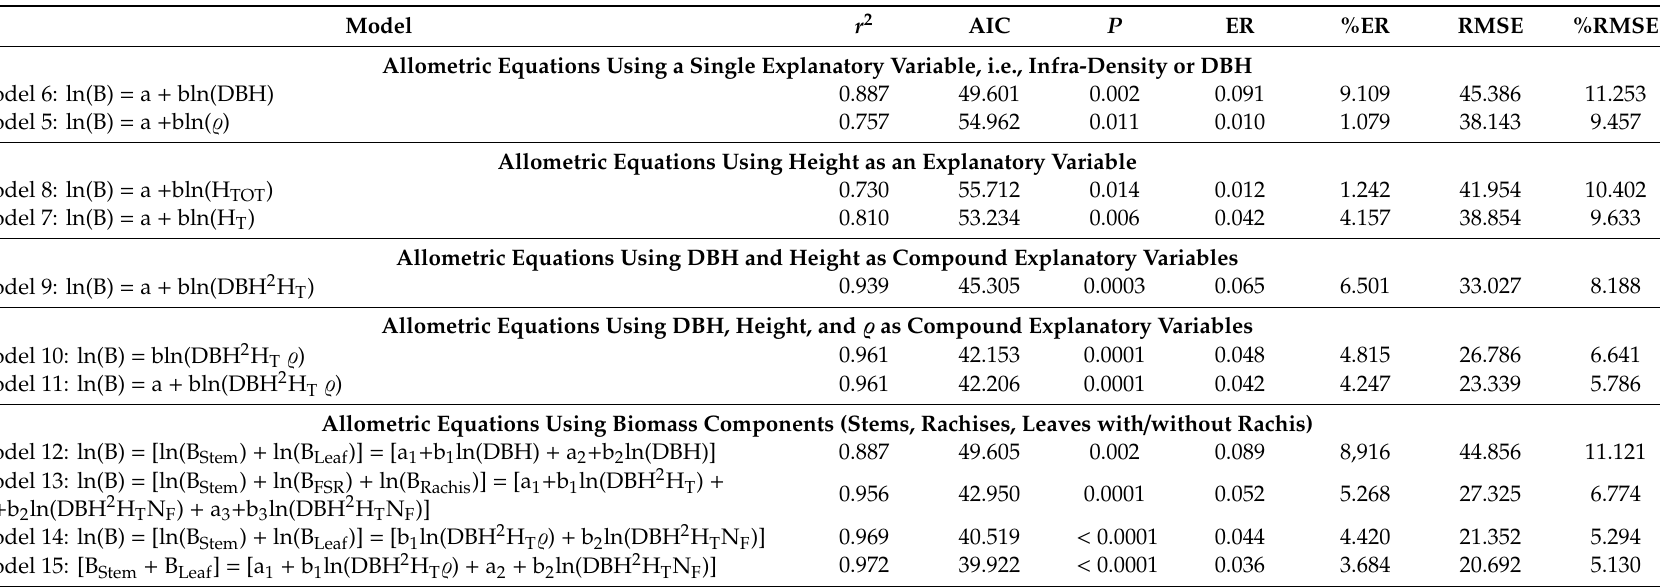
Table 7. Validation of the local allometric models of oil palm biomass; estimates for a and b are available in Table 5. Model r 2 AIC P ER %ER RMSE